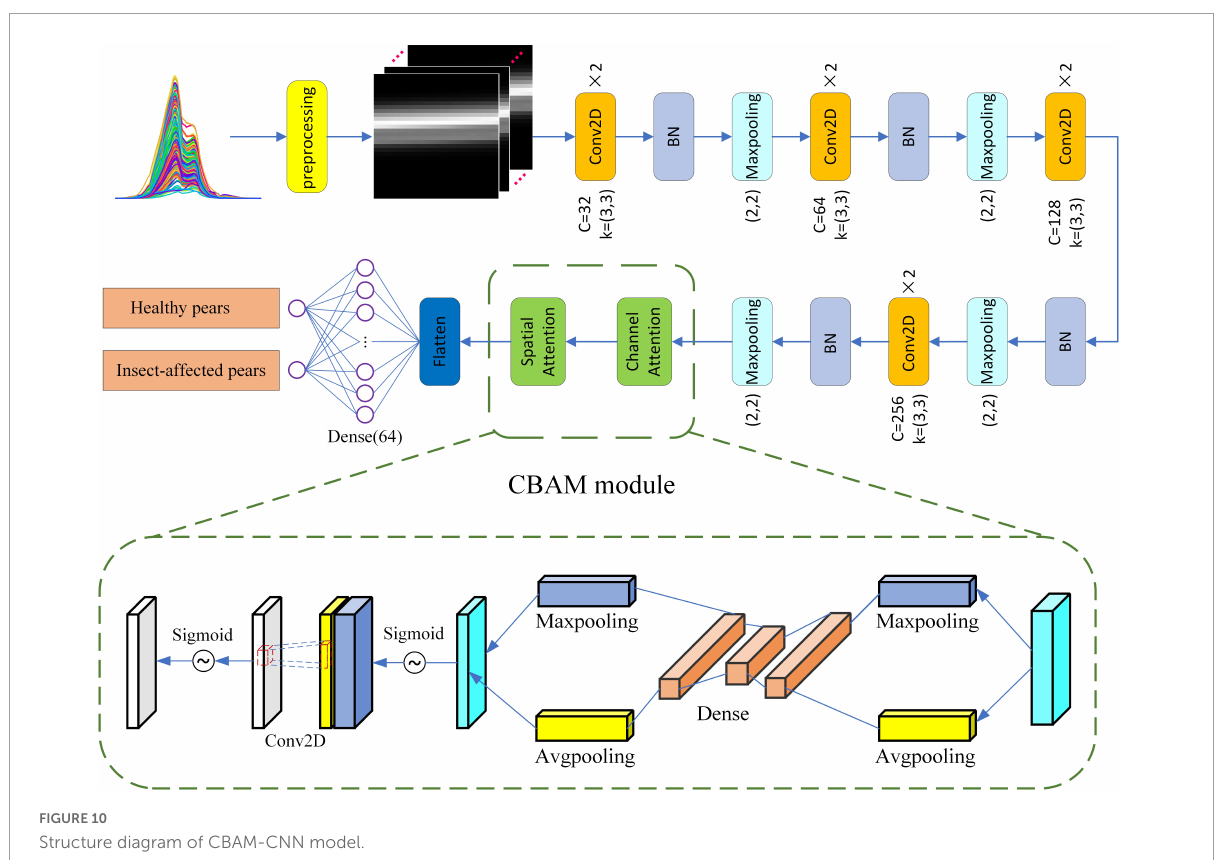
FIGURE10 Structure diagram of CBAM-CNN